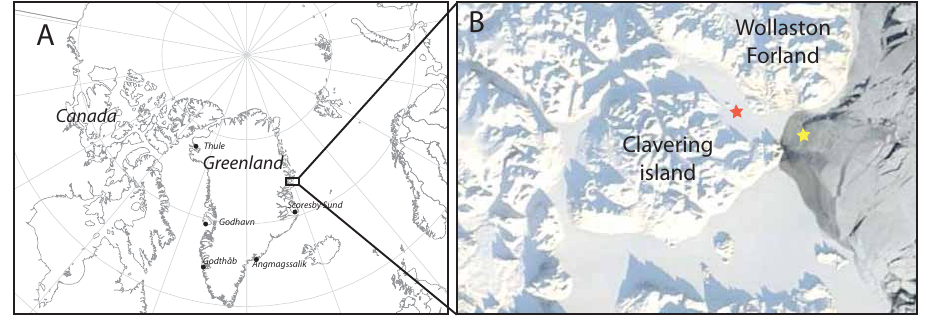
Fig. 1. Study site. (A) Greenland showing the study area (box) and (B) the Young Sound fjord between Wollaston Forland and Clavering Island. Sea ice coring sites for the land-fast ice location (ICE I) is shown as a red star and the polynya coring site (POLY I) as a yellow star. The satellite image showing land-fast ice in the fjord and thin ice–open water conditions in the polynya outside the fjord is from early March